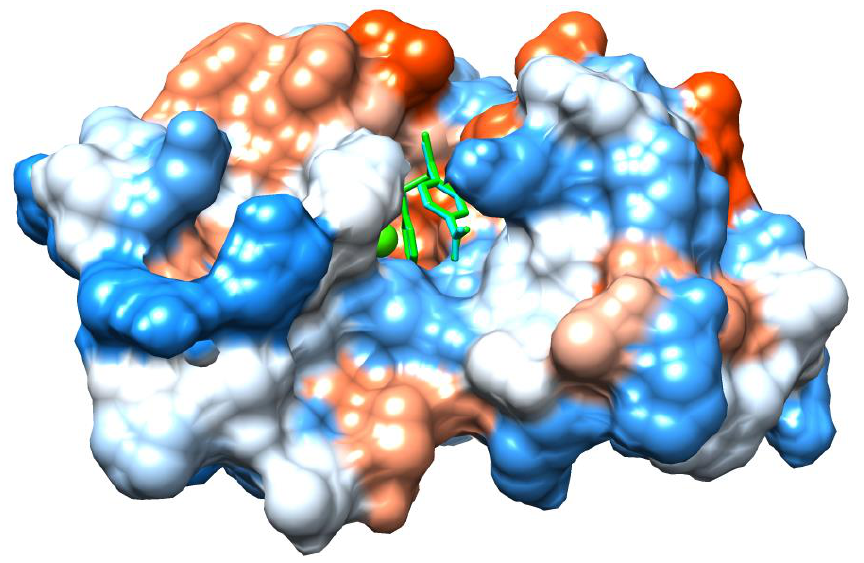
Figure 6. Docking conformations with highest affinities of I (green) and II (cyan) inside the hydrophobic channel of PLA 2.